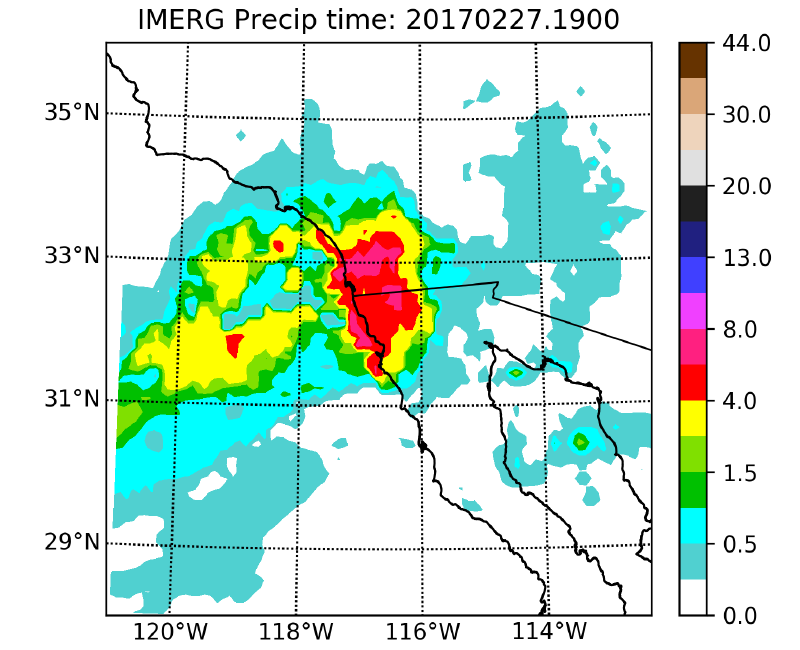
Figure 3. Hourly precipitation estimates (in mm/h) from IMERG. Valid for 27 February 2017 at 19